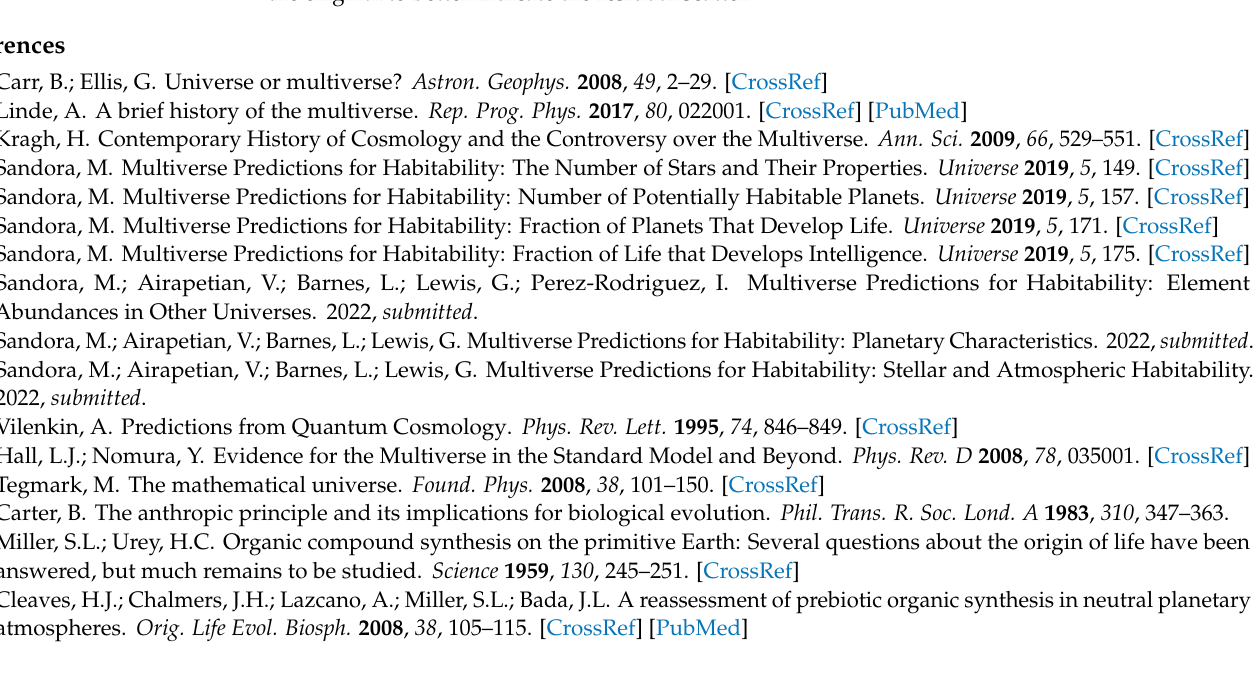
Figure A2. Comparison of Bayes factor using k SEP “ 1 with Bayes factors using altered k SEP . Each dot is a combination of habitability criteria. The left plot compares the two Bayes factors directly and indicates a strong correlation with some scatter. The right plot divides the new Bayes factor by the original to better indicate the residual